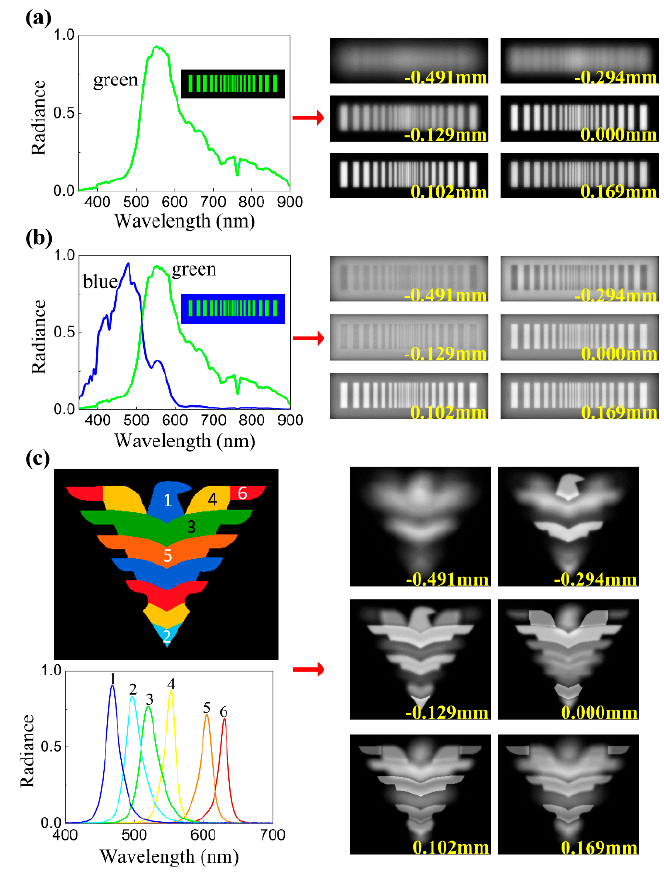
Figure 3. Blurred images of three objects formed on the detection plane. The left column shows the objects and the radiation spectrum for each color, and the right column denotes the blurred images formed on the detection plane. We consider the position corresponding to 550 nm focused as the zero position, and only show six images where the detection plane is at − 0.491 mm, − 0.294 mm, − 0.129 mm, 0 mm, 0.102 mm, and 0.168 mm. ( a , b ) Radiation spectrum and blurred images on detection plane of green stripes with black background target and green stripes with blue background object. Light wavelength below 400 nm and exceeding 700 nm is not considered in the imaging. ( c ) Six-color ZJU logo. The radiation spectrum of each color in the object is correspondingly numbered, and the number-labeled positions are approximately the Region of Interests (ROIs).